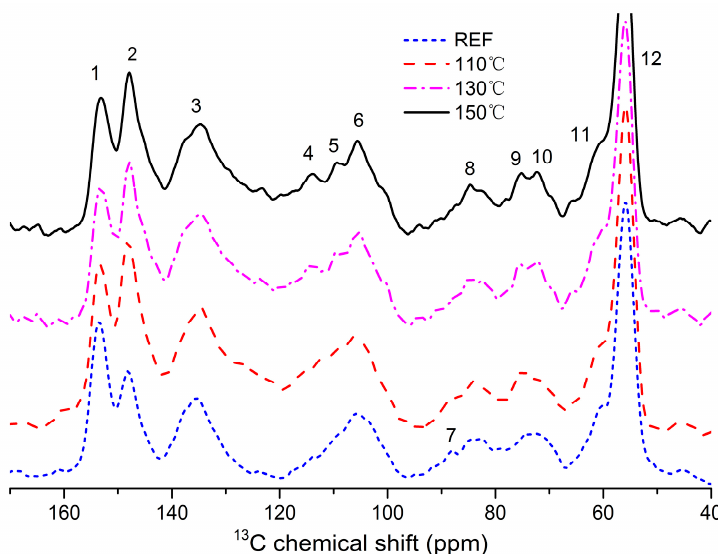
Figure 4. The 13 C NMR spectrum of dioxane lignin isolated from treated wood samples.